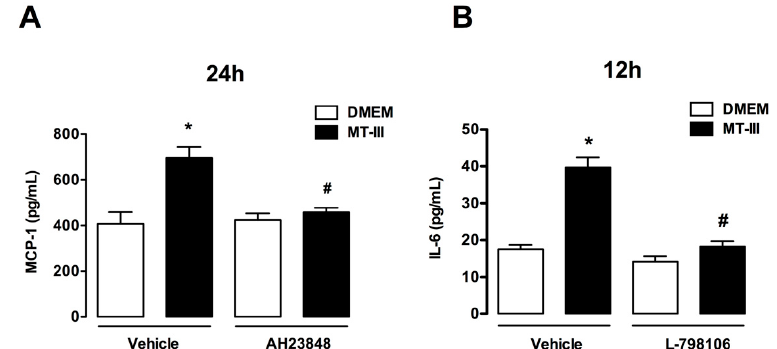
Figure7. EP3andEP4receptorsparticipateintheMT-III-inducedreleaseofIL-6andMCP-1, respectively, by 3T3-L1 preadipocytes. Cells were incubated with AH23848 (10 µ M) or L-798106 (1 µ M) or vehicle for 1 h followed by incubation with MT-III (0,4 µ M) for 12 or 24 h. Graphs show participation of EP4 receptor in the MT-III-induced release of MCP-1 ( A ) and participation of the EP3 receptor in the MT-III-induced release of IL-6 ( B ). Concentration of cytokines were quantified from culture supernatants by Cytometric Bead Array (CBA). Results are expressed as mean ± SEM from 5 experiments. * p < 0.05 as compared with control group and # p < 0.05 as compared with MT-III group (one-way ANOVA and Bonferroni